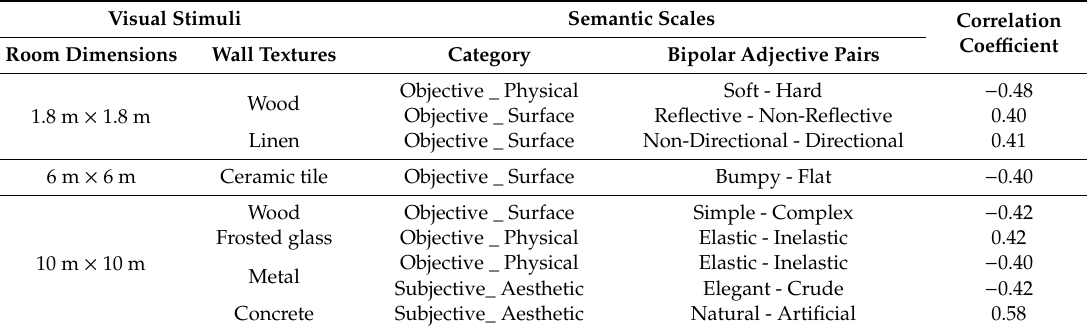
Table 7. Correlation between ER Value of Wall Textures and Score on Semantic